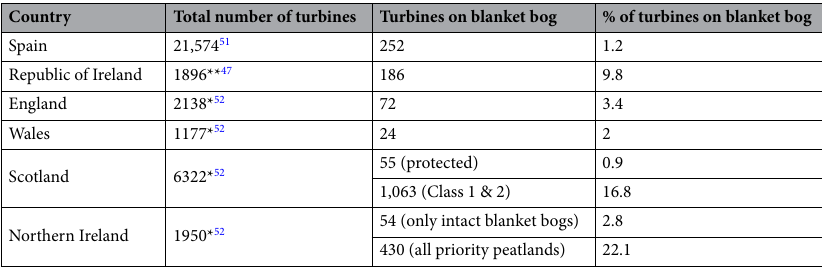
Table 3. Total % of turbines on blanket bog (recognised/national inventories) in relation with the total turbines installed by country . *Include wind turbines consented, operational and under construction. **Include proposed, constructed and under